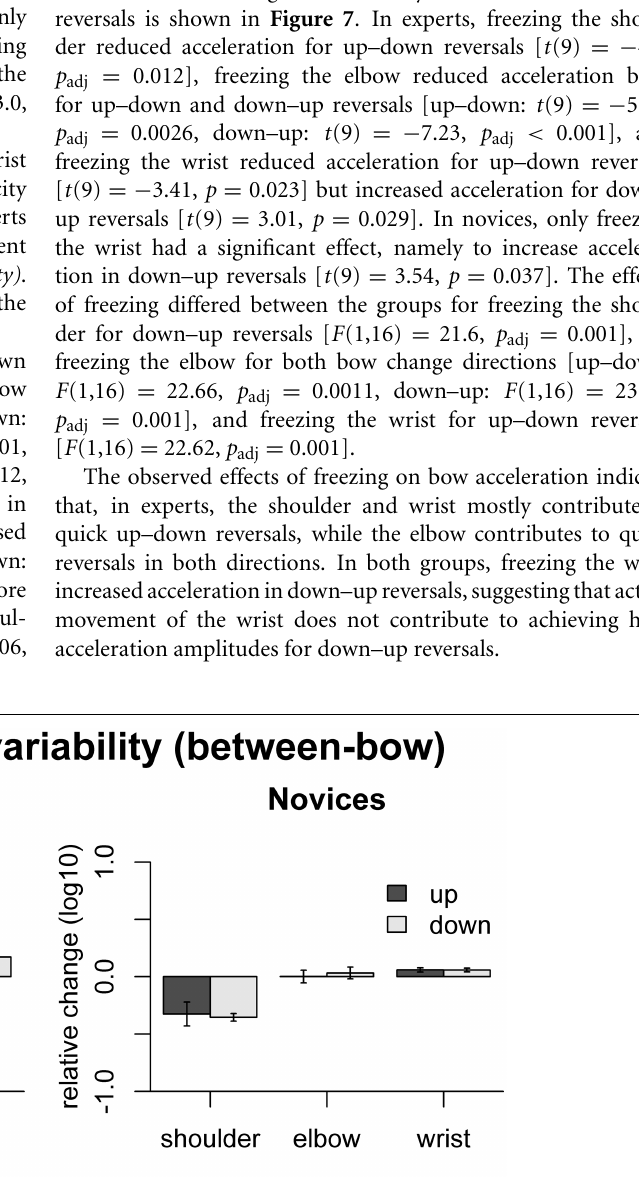
Frontiers in Psychology | Cognitive